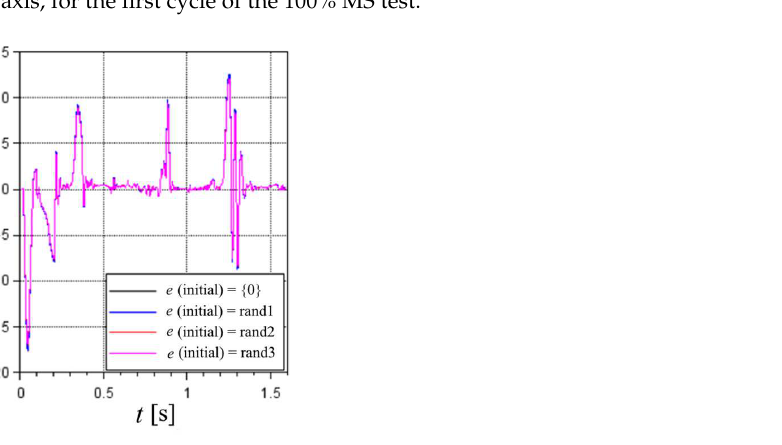
in the ( a ) X axis and :